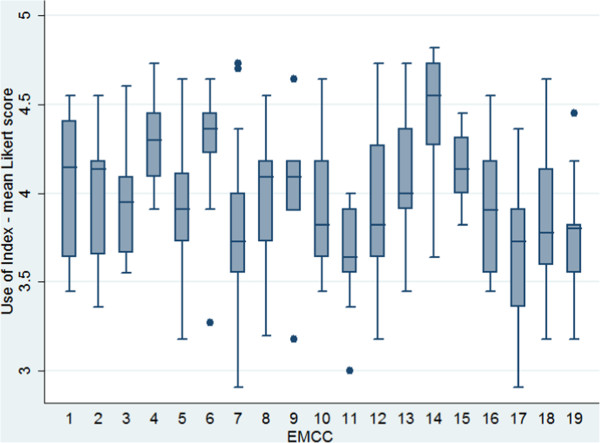
Use of Index between the EMCCs. Box plot of mean Likert-score values, displaying use of Index between the different EMCCs. The box represent the first, second (median) and third quartile of the data. The whiskers show the lowest datum within 1.5 interquartile range of the first quartile, and the highest datum within 1.5 interquartile range of the third quartile. Outliers are shown as dots.